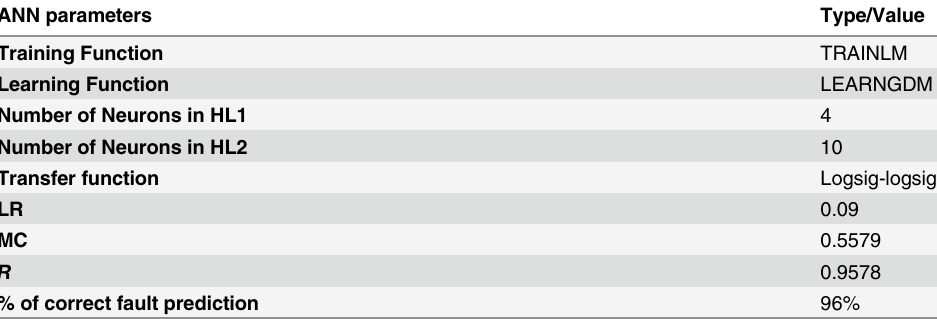
Table 5. Properties of the selected ANN combined with